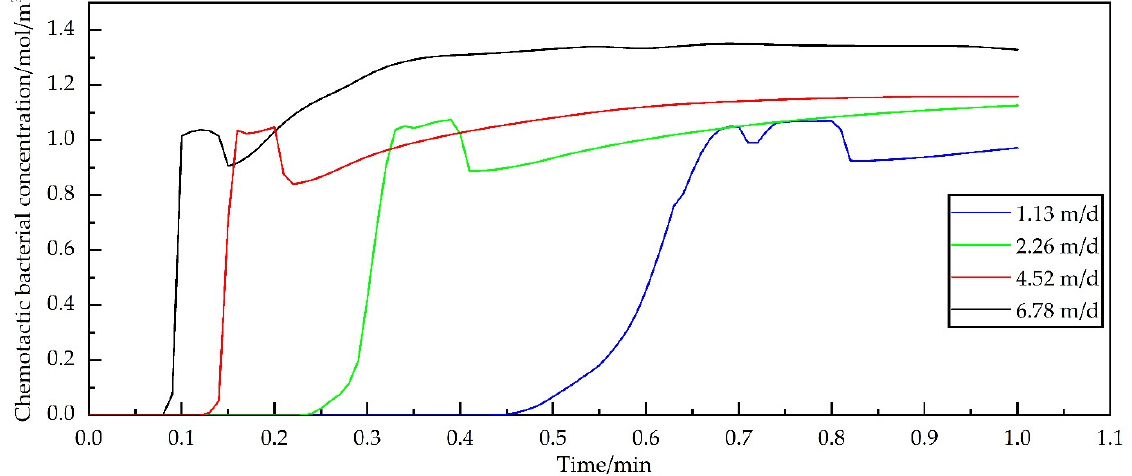
Figure 10. The concentration change of chemotactic bacteria at a point of the phase interface with